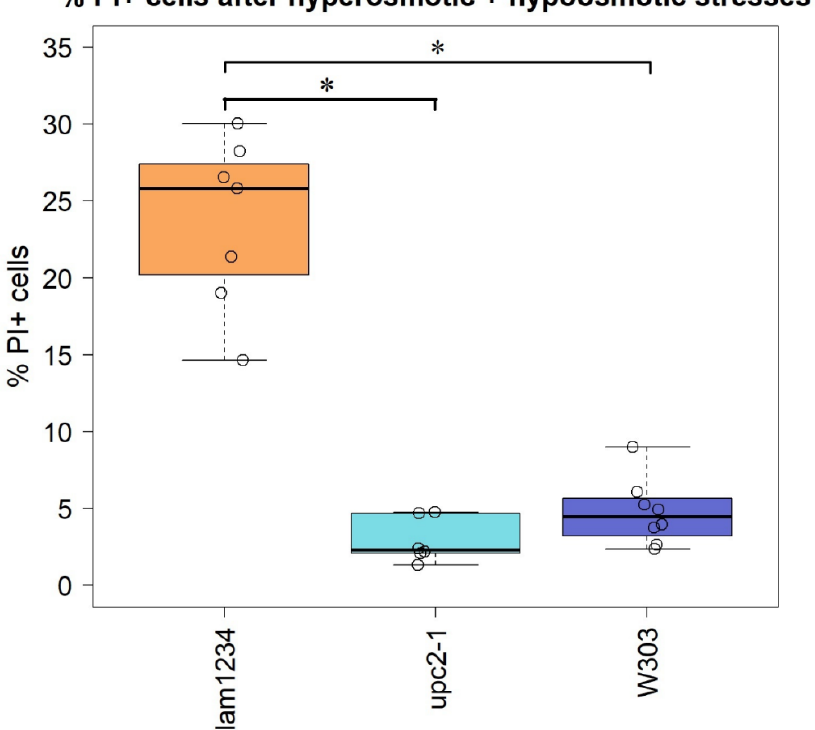
Figure 5. S. cerevisiae ∆ lam1 ∆ lam2 ∆ lam3 ∆ lam4 (lam 1234) mutant cells accumulate propidium iodide after hypoosmotic stress. Circles are individual experimental repeat measurements. * p < 0.05, Two-sample t-test for independent samples.